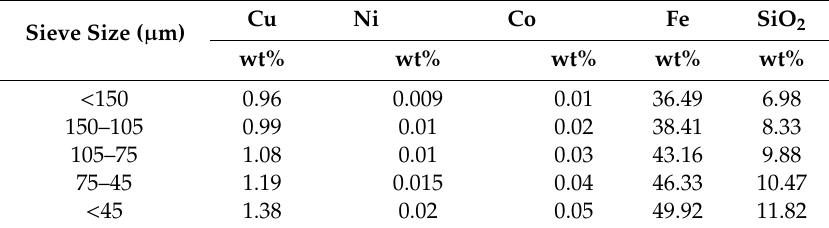
Table 1. Sieve analysis of di ff erent fractions of converter slag.